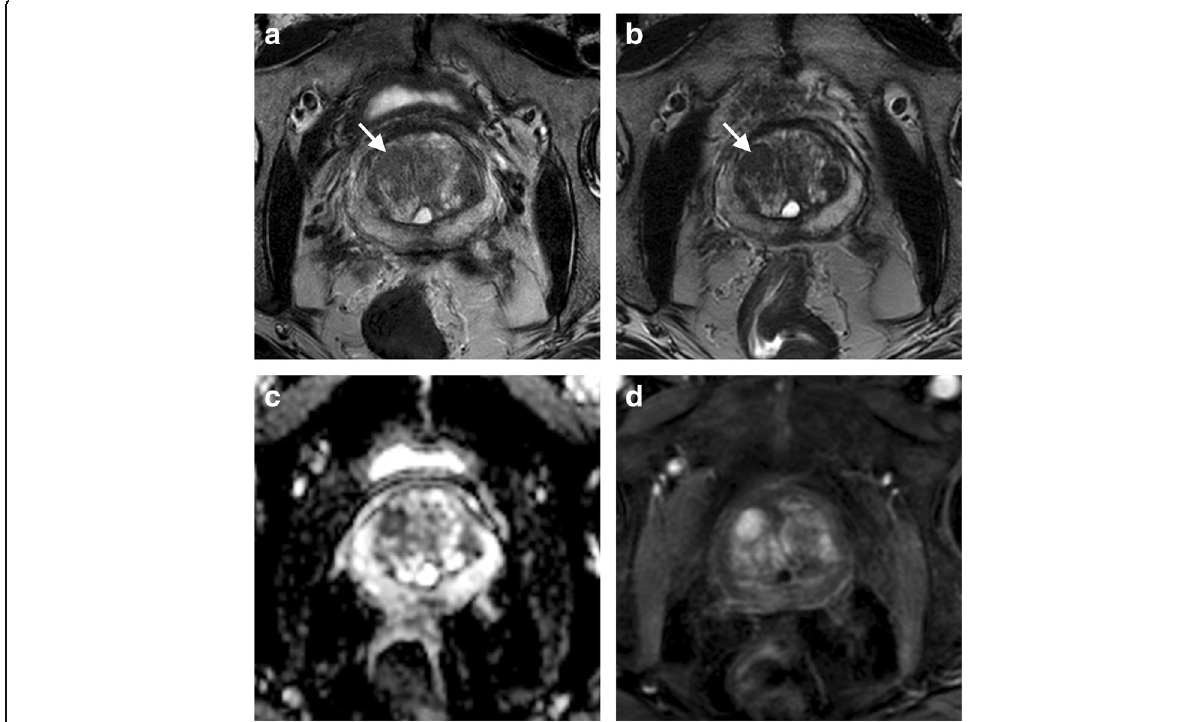
Fig. 4 Three-dimensional (3D) T2-weighted imaging in a biopsy-naïve 69-year-old patient with elevated PSA (5.39 ng/mL) undergoing mpMRI for the purpose of targeted biopsy. The examination showed a nodule in the right TZ showing moderate hypointensity on transverse two- dimensional T2-weighted imaging and somewhat ill-defined margins (arrow in a ). 3D T2-weighted imaging better delineated the nodule margins as a “ charcoal ” peripheral rim (arrow in b ) by reducing image blurring, thus contributing to characterise it as a benign prostate hyperthropy (BPH) fibrostromal nodule. The nodule showed restricted diffusion (hypointensity on the ADC map in c ) and intense, early contrast enhancement on transverse fat-saturated T1-weighted imaging ( d